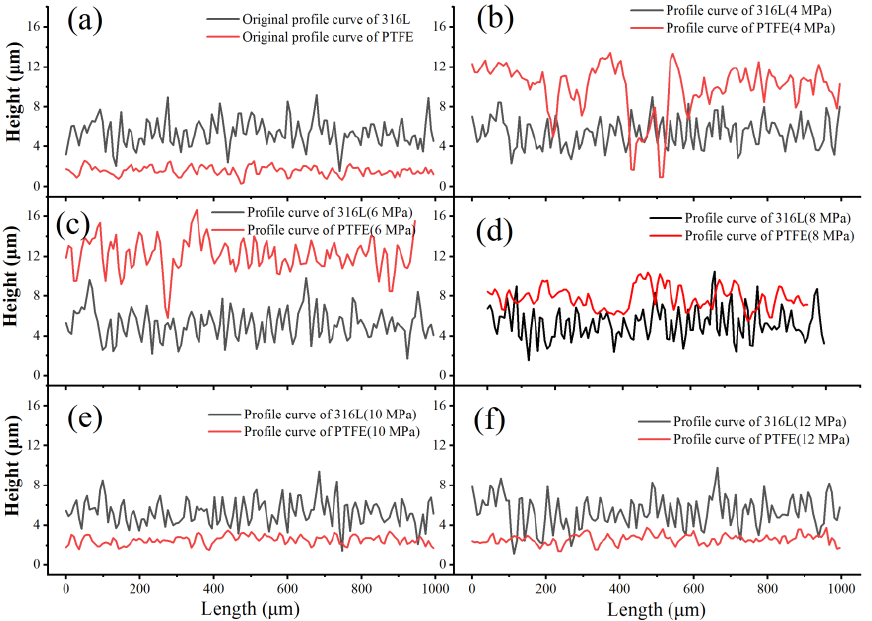
Figure 8. The profile curves of 316L sample and PTFE sample after friction experiments: ( a ) the original profile curves; ( b ) the lubrication pressure of 4 MPa; ( c ) the lubrication pressure of 6MPa; ( d ) the lubrication pressure of 8 MPa; ( e ) the lubrication pressure of 10 MPa; ( f ) the lubrication pressure of 12 MPa.